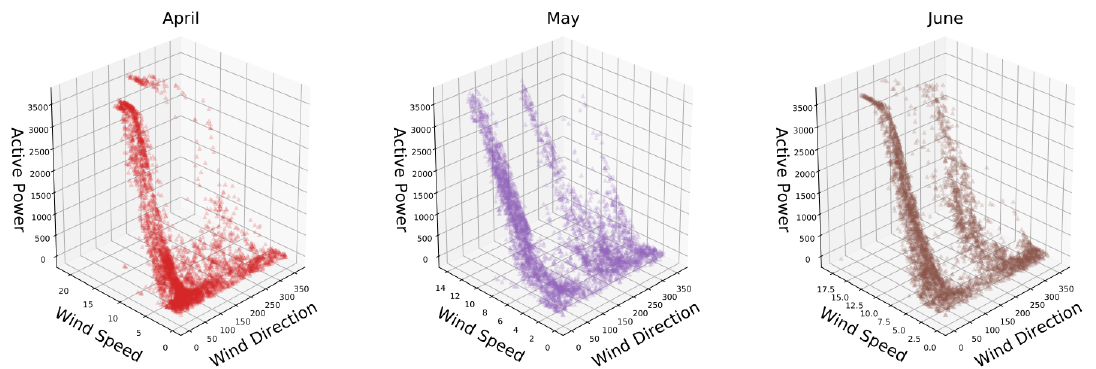
Figure 5. Scatter plot for the months of July, September and October individually along with Wind Direction, Wind Speed, and Active Power.